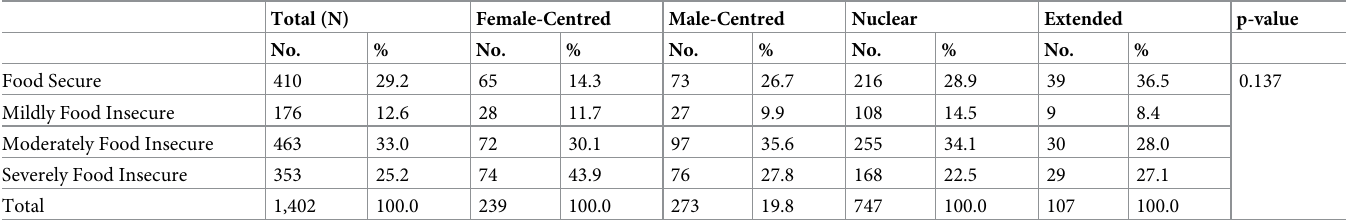
Table 3. Levels of household food insecurity in Nairobi by household